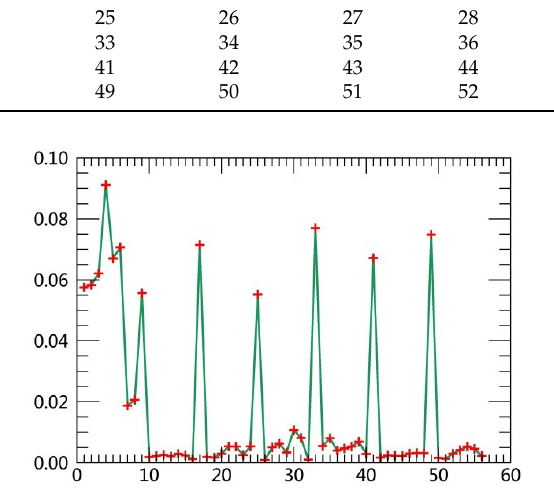
Figure 1. Weight line chart of 54 features in 1990.